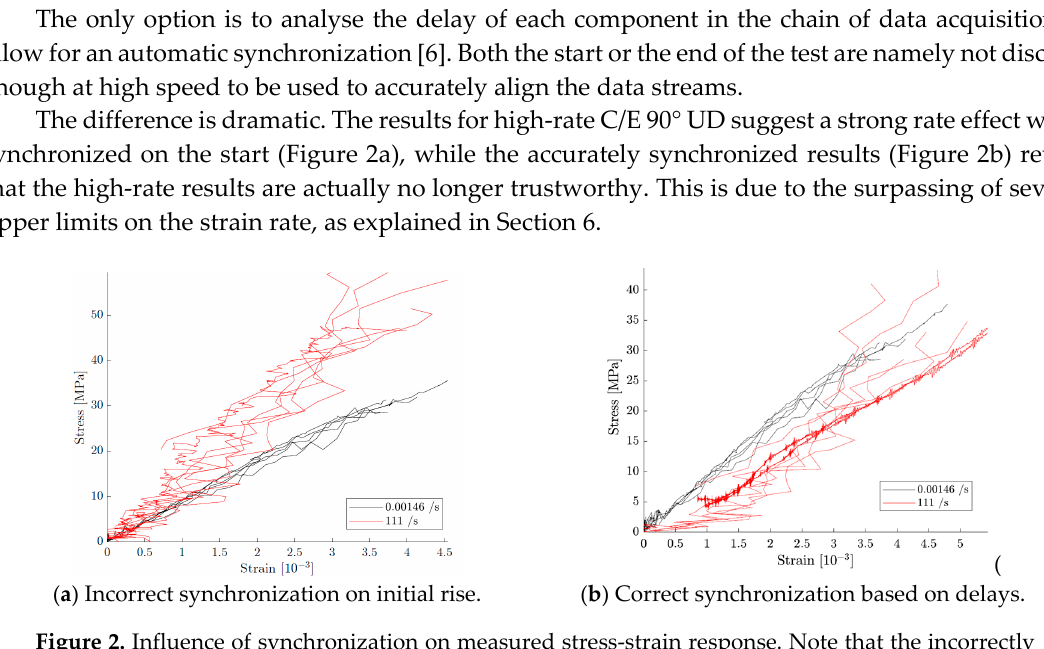
Figure 2. Influence of synchronization on measured stress-strain response. Note that the incorrectly synchronized results ( left ) seem more logical than the correct synchronization ( right ) at first glance, though the suggested rate effect is caused by the surpassing of several upper limits in strain rate.